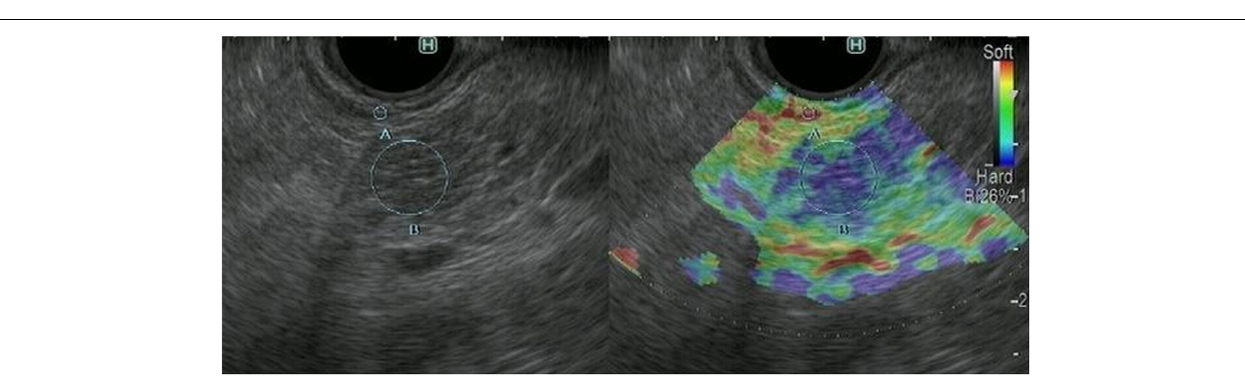
Frontiers in Physiology |